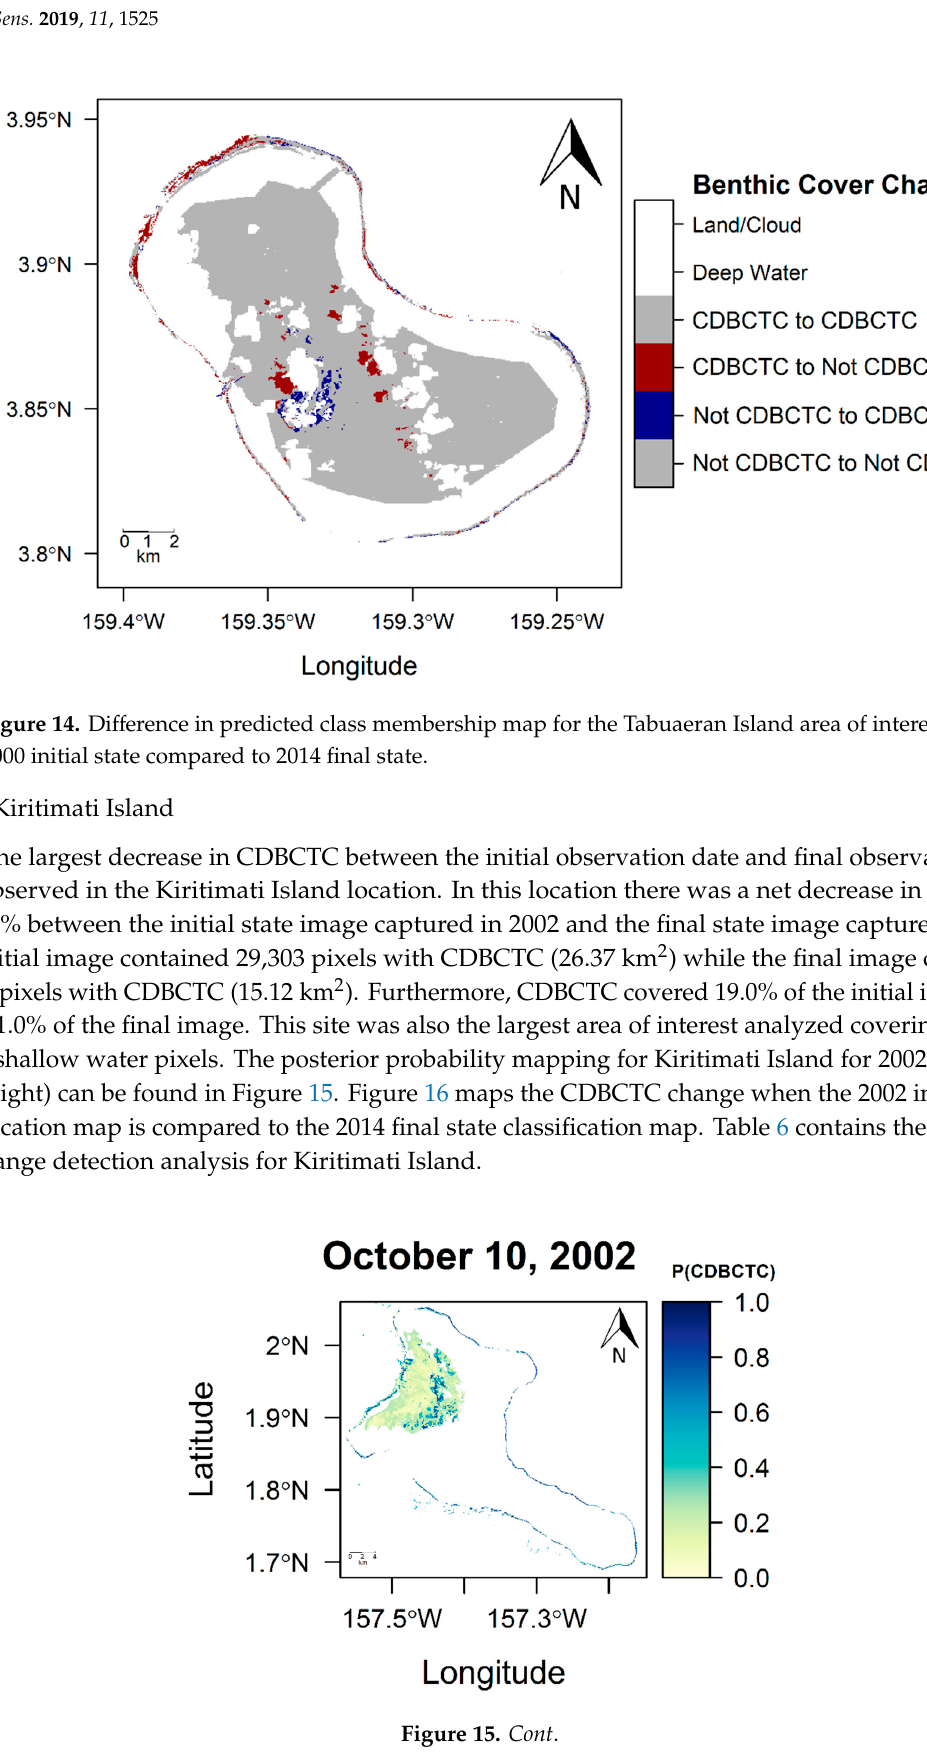
Figure 15. Posterior probability map for the Kiritimati Island area of interest (left, 2002 and right, 2014).